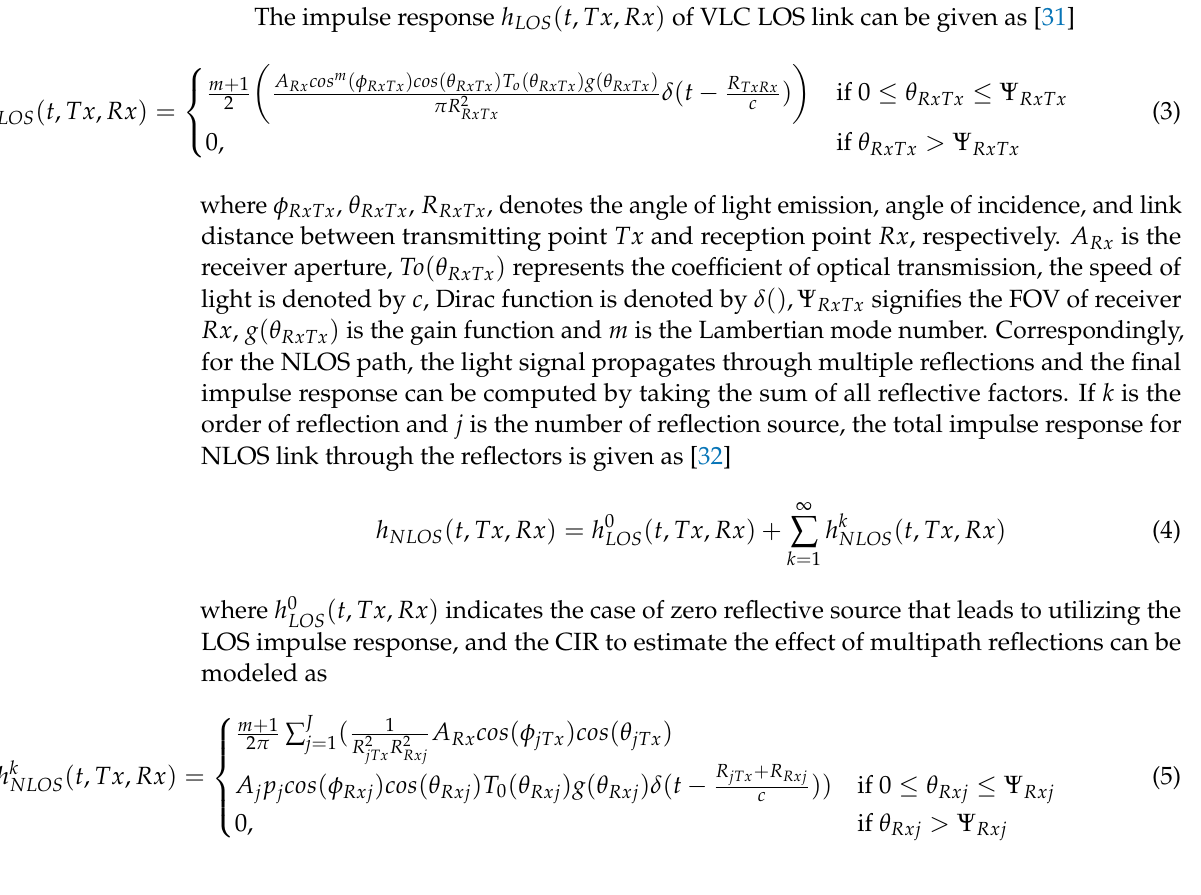
Figure 3. Geometrical classification of VLC link in terms of line of sight (LOS) and non-line of sight (NLOS)